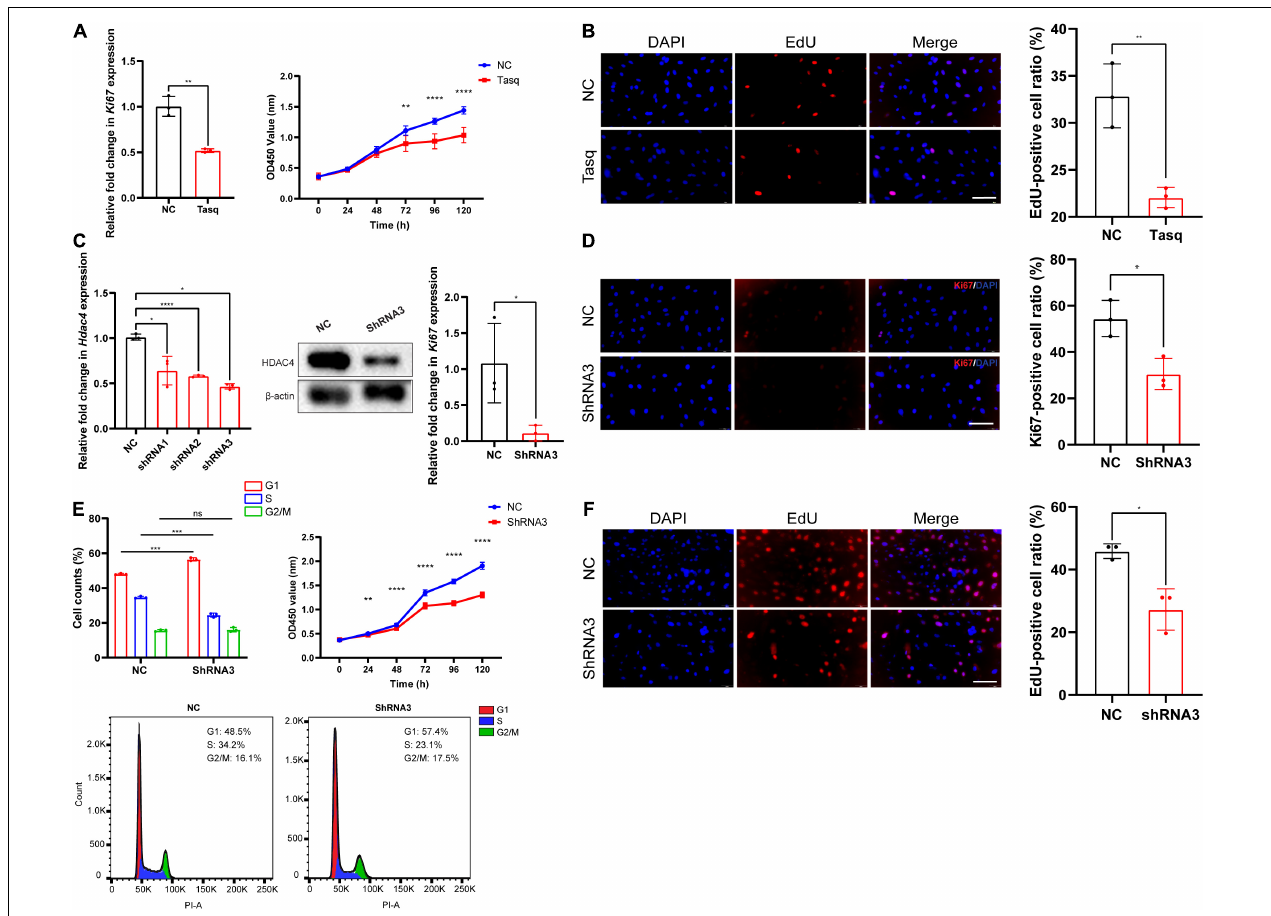
FIGURE 3 | The effect of Hdac4 on the proliferation of MC3T3-E1 cells. (A) RT-qPCR analysis of Ki67 expression in cells treated with tasquinimod (Tasq) (10 µ M) for 7 days. Cell proliferation assays were performed for control and tasquinimod-treated (10 µ M) cells at 0, 24, 48, 72, 96, or 120 h (0–5 days). (B) Images and quantification of EdU staining (red) in MC3T3-E1 cells after treatment with 10 µ M tasquinimod for 7 days. Nuclei were counterstained with DAPI (blue). Scale bar, 100 µ m. (C) RT-qPCR analysis of Hdac4 knockdown in MC3T3-E1 cells transfected with negative control (NC) or one of three Hdac4-specific shRNAs ( n = 3). Western blotting of HDAC4 in control and shRNA3-transfected cells. RT-qPCR of Ki67 in control and Hdac4 knockdown cells. (D) Immunofluorescence staining of Ki67 in control and shRNA3-transfected cells. (E) Flow cytometric analysis of the effect of Hdac4 knockdown on the cell cycle. The bar graph represents the percentage distribution of control and Hdac4 knockdown cells in different phases of the cell cycle. The cell cycle distribution of control and Hdac4 knockdown cells is shown. Cell proliferation assays were performed in control and Hdac4 knockdown cells at 0, 24, 48, 72, 96, or 120 h after transfection (day 0–5). (F) Images and quantification of EdU staining (red) in control and Hdac4 knockdown cells. Nuclei were counterstained with DAPI (blue). Scale bar, 100 µ m. * P < 0.05; ** P < 0.01; *** P < 0.001; **** P <